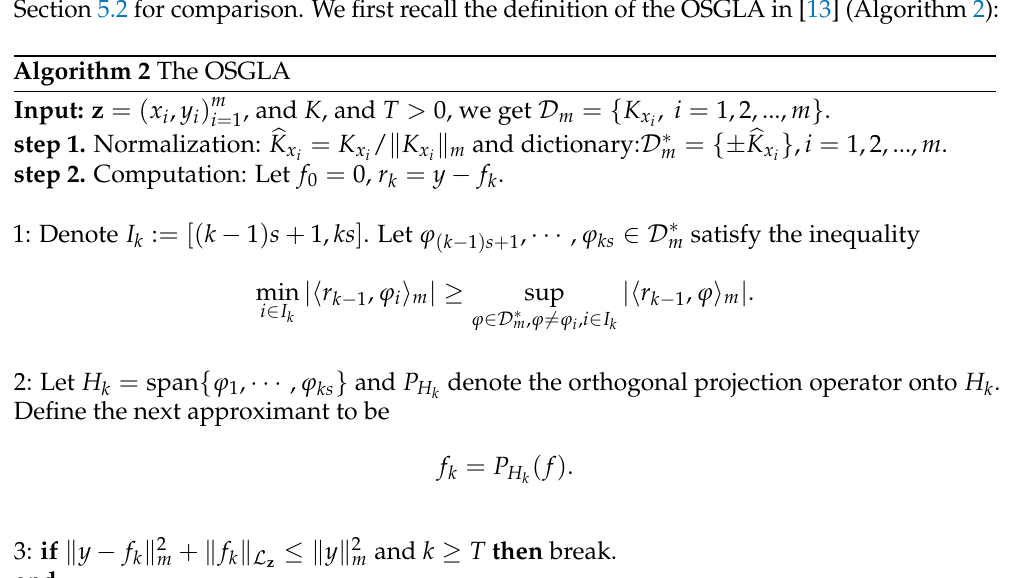
Table 1. Additionally, the running time of the RPGLA, OSGLA, and RPSGLA on different types of data are reported in Table